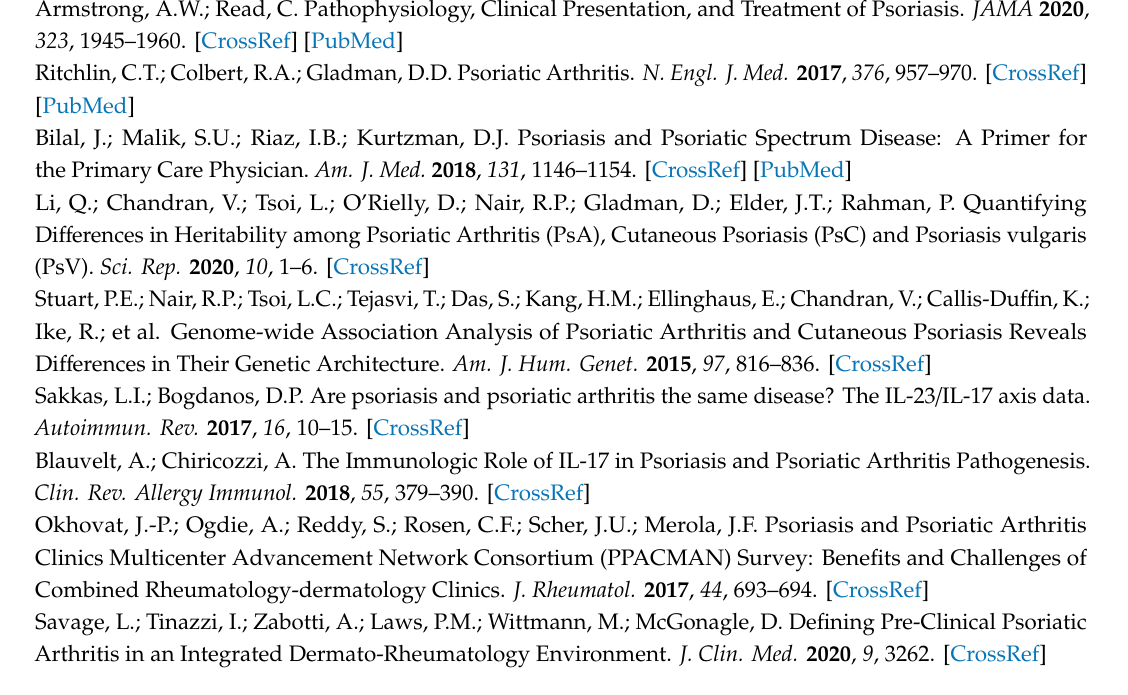
studies; Table S3: Modified Newcastle-Ottawa Scale for cross-sectional studies; Table S4: Characteristics of included studies; Figure S1: Doi plot and LFK index of femoral neck BMD; Figure S2: Doi plot and LFK index of lumbar spine BMD; Figure S3: Doi plot and LFK index of